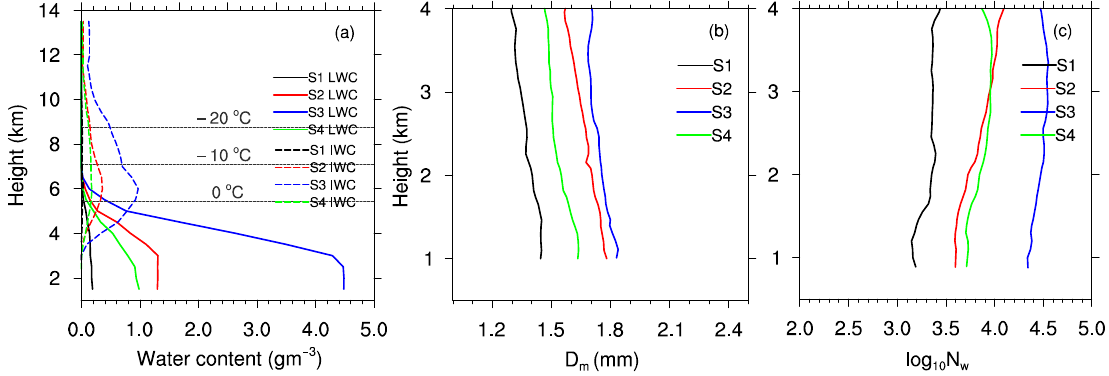
Figure 10. ( a ) Mean values of ice (dashed) and liquid (solid) water content (g m − 3 ) over Jinjiang at the four stages. The grey dashed lines represent the level of 0 °C, − 10 °C, and − 20 °C from bo tt om to top. Mean profiles of ( b ) D m (mm) and ( c ) log 10 N w (units of N w : mm − 1 m − 3 ) over Jinjiang at the four stages. The black, red, blue and green lines represent the initial (S1), developing (S2), mature (S3), and dissipating stages, respectively.